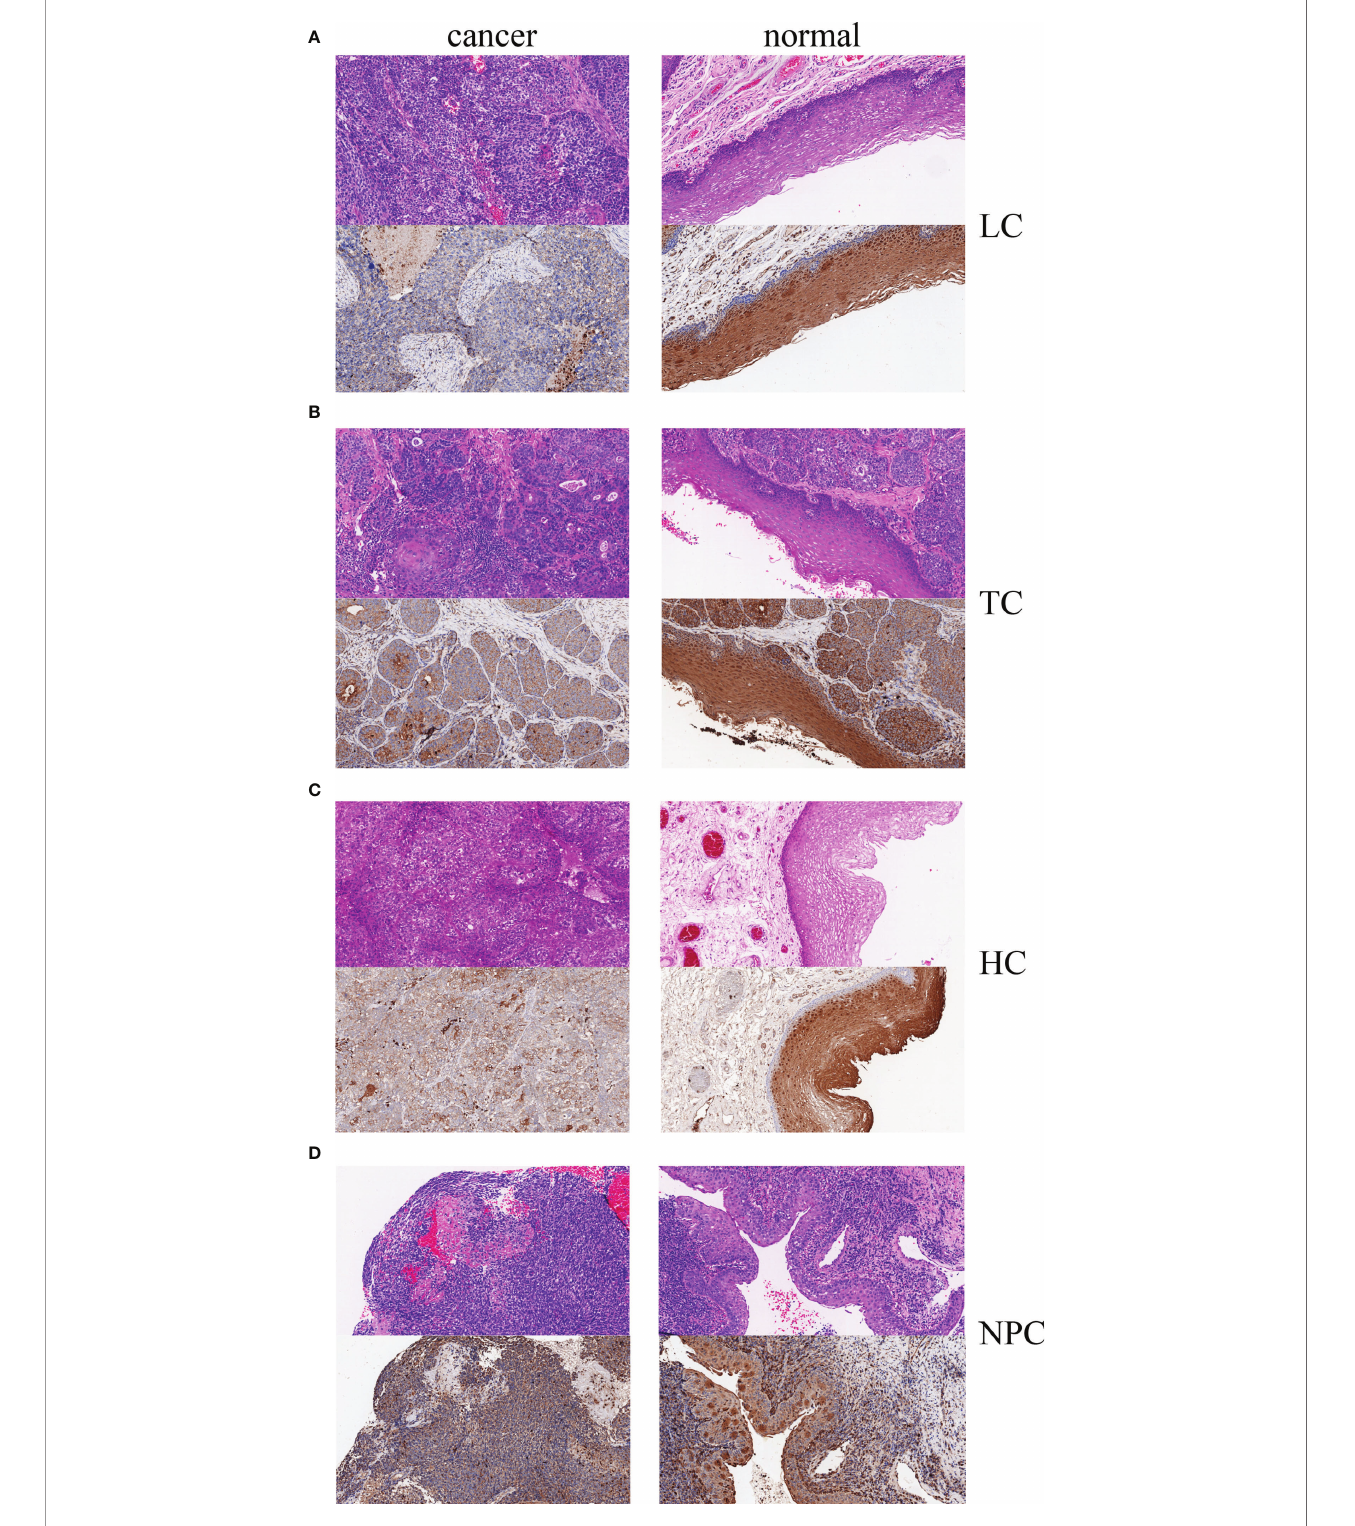
FIGURE 9 | Hematoxylin-eosin (HE) staining and IHC offour HNC types, (A) LC, laryngeal cancer, (B) TC: tongue cancer, (C) HC, hypopharyngeal cancer, and (D) NPC, nasopharyngeal